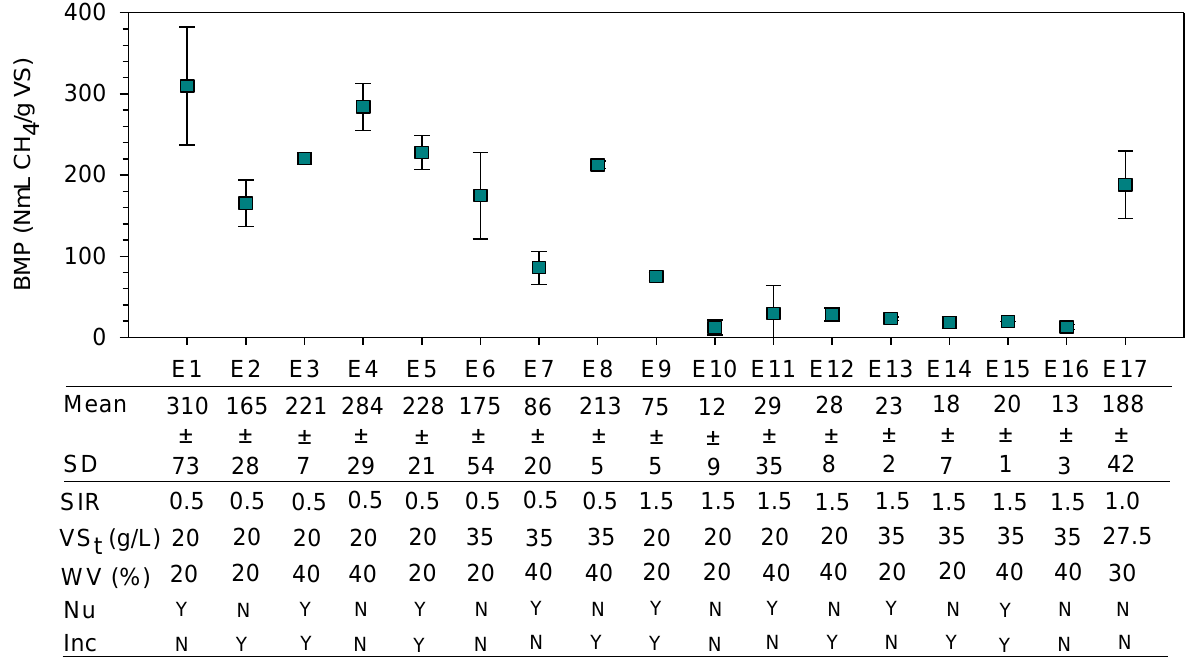
Figure 1. Mean of the BMP and respective standard deviation (SD), and operating conditions for each experiment.